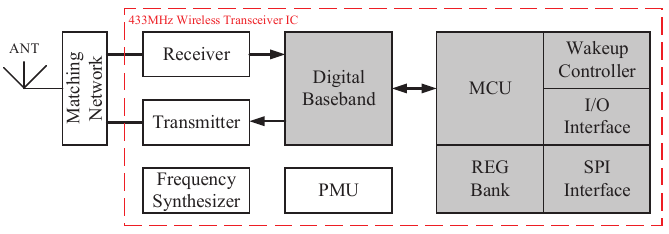
Figure 4. Block diagram of the wireless